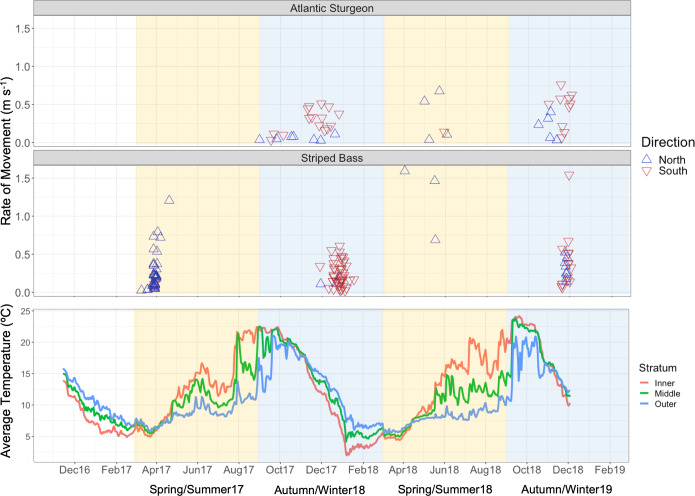
Summary of transit information by species from November 2016—December
2018.Shading denotes separate migration seasons (Spring/Summer = yellow,
Autumn/Winter = blue). Plots include direction and rate of transit for
each study species (top two panels) and average bottom temperature
recorded by receivers (bottom panel).